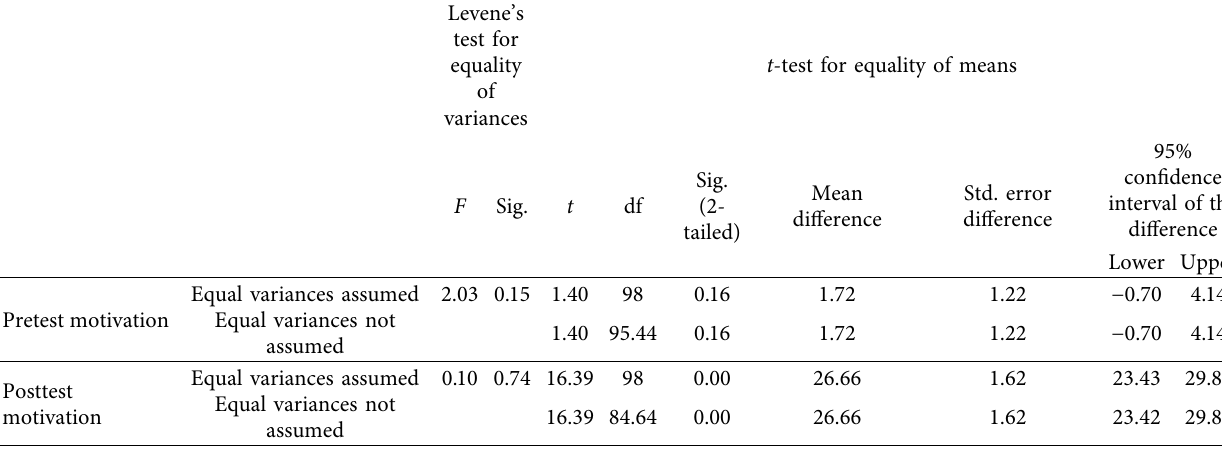
Table 4: Results of independent-samples t -test comparing the pretest motivation and posttest motivation scores.